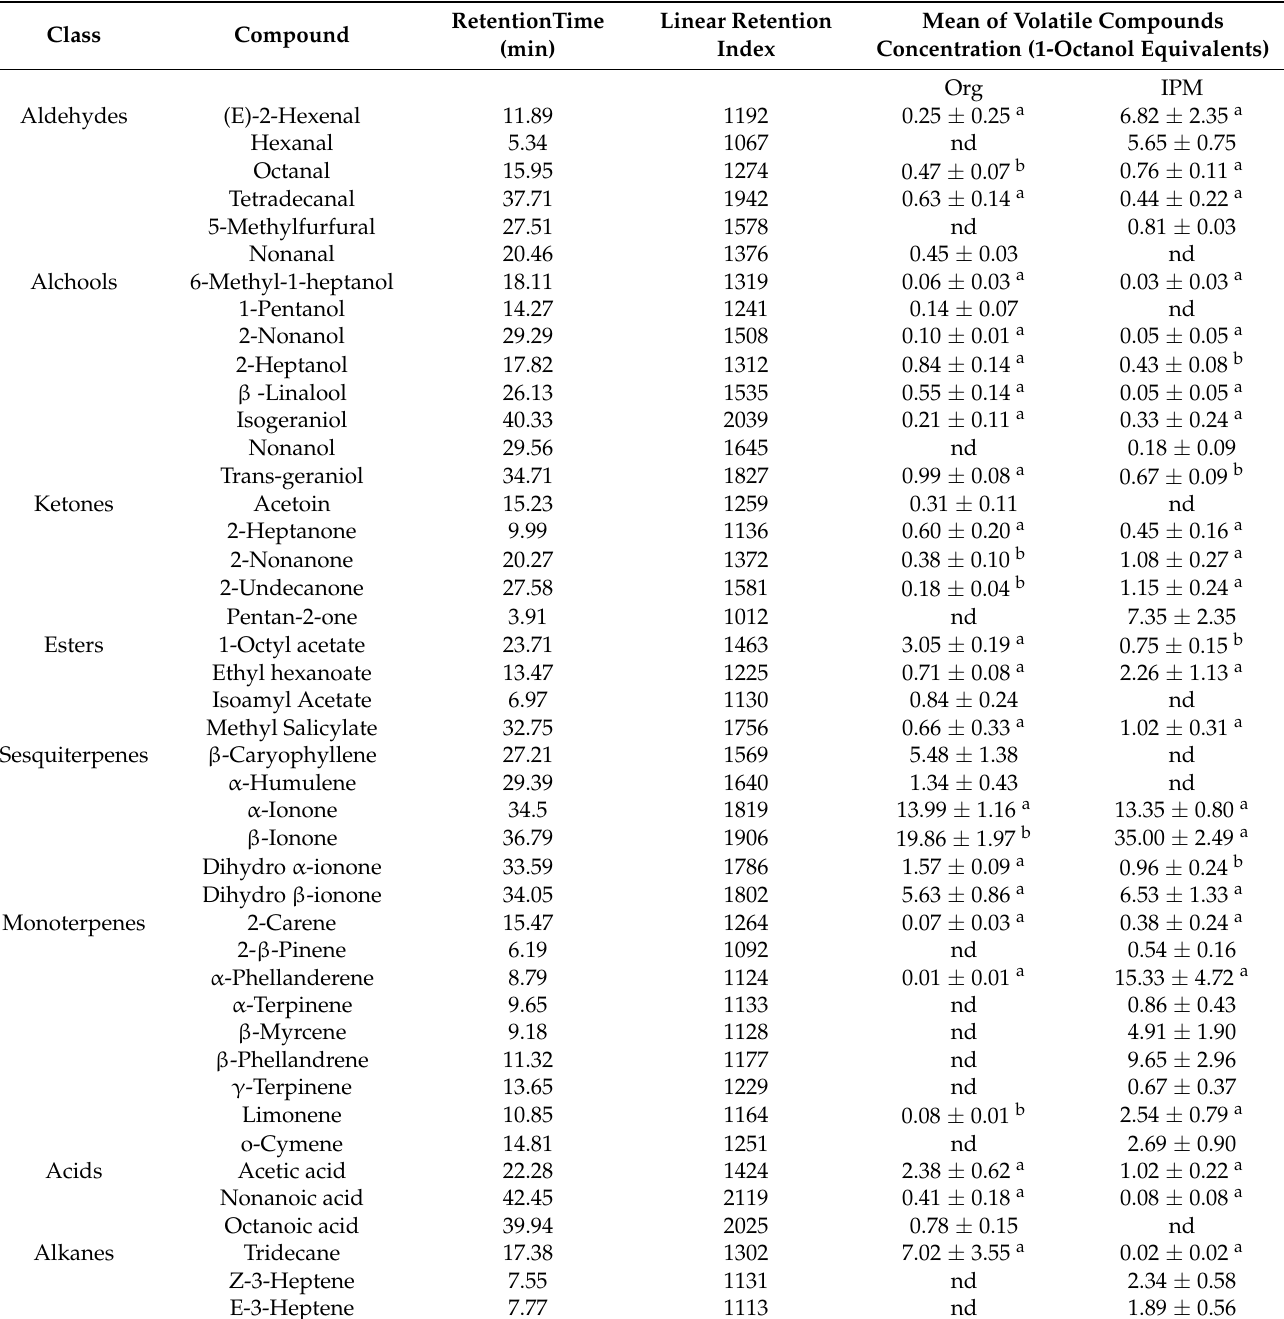
Table 3. Volatile organic compounds emitted by raspberry fruit ‘Enrosadira’ cultivated with organic (Org) or integrated (IPM) practices. Data are reported as mean ± SE. Values labelled with different letters indicates significant differences between the cultivation methods according to Student’s t -test at p -value < 0.05. nd = not